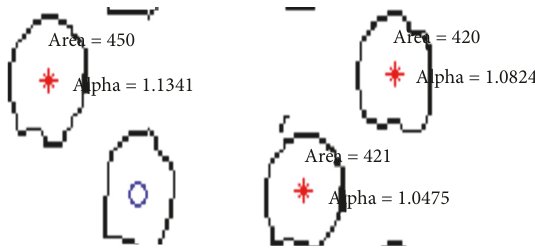
Figure 6: Features extraction examples. Both “ ∗ ” and “o” indicate the gravity coordinate (𝑥 𝑔 , 𝑦 𝑔 )